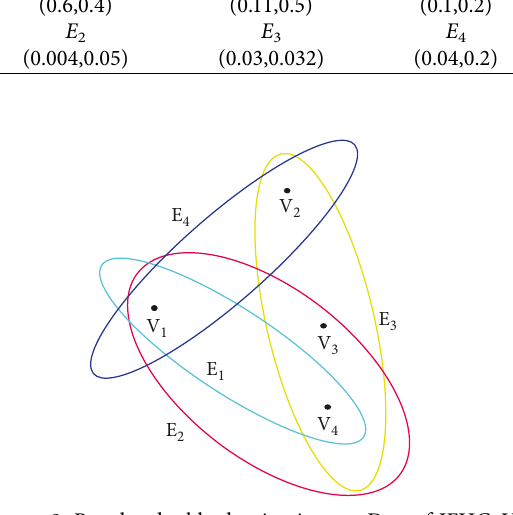
H . r 2 h of IFHG